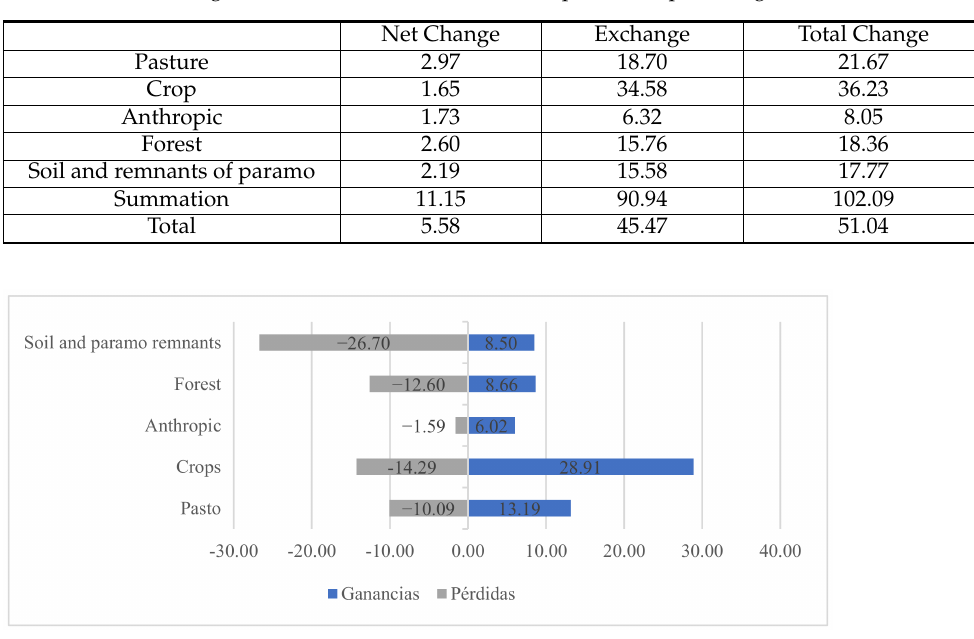
Table 7. Rate of change of the time interval 2009–2019 expressed in percentage terms.